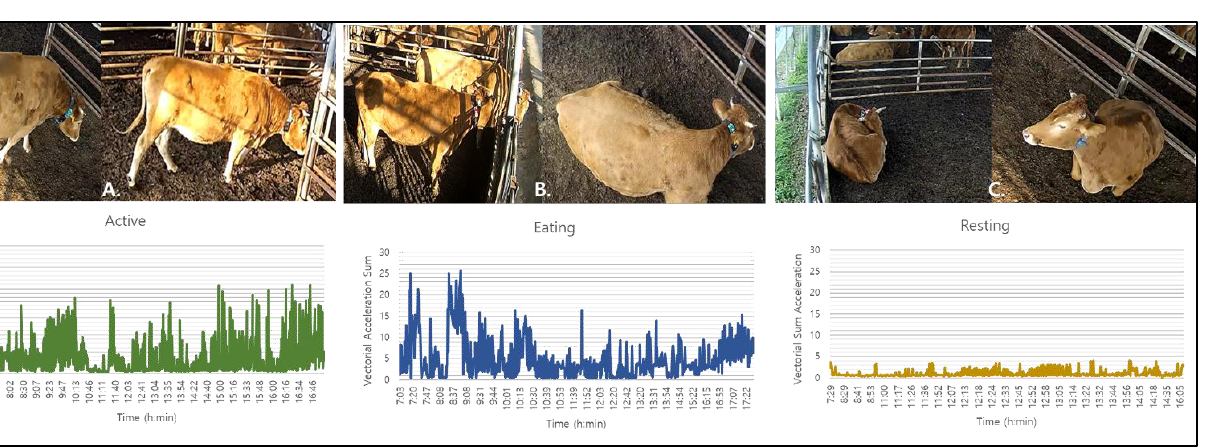
Figure 3. The three major cattle behaviors studied were ( A ) active behavior (standing and walking motions), ( B ) eating behavior (feeding, ruminating, and drinking motions), and ( C ) resting behavior (sleeping and lying motions). Below each behavior were the graphs of the vectorial sum acceleration per minute of the three major cattle behaviors.